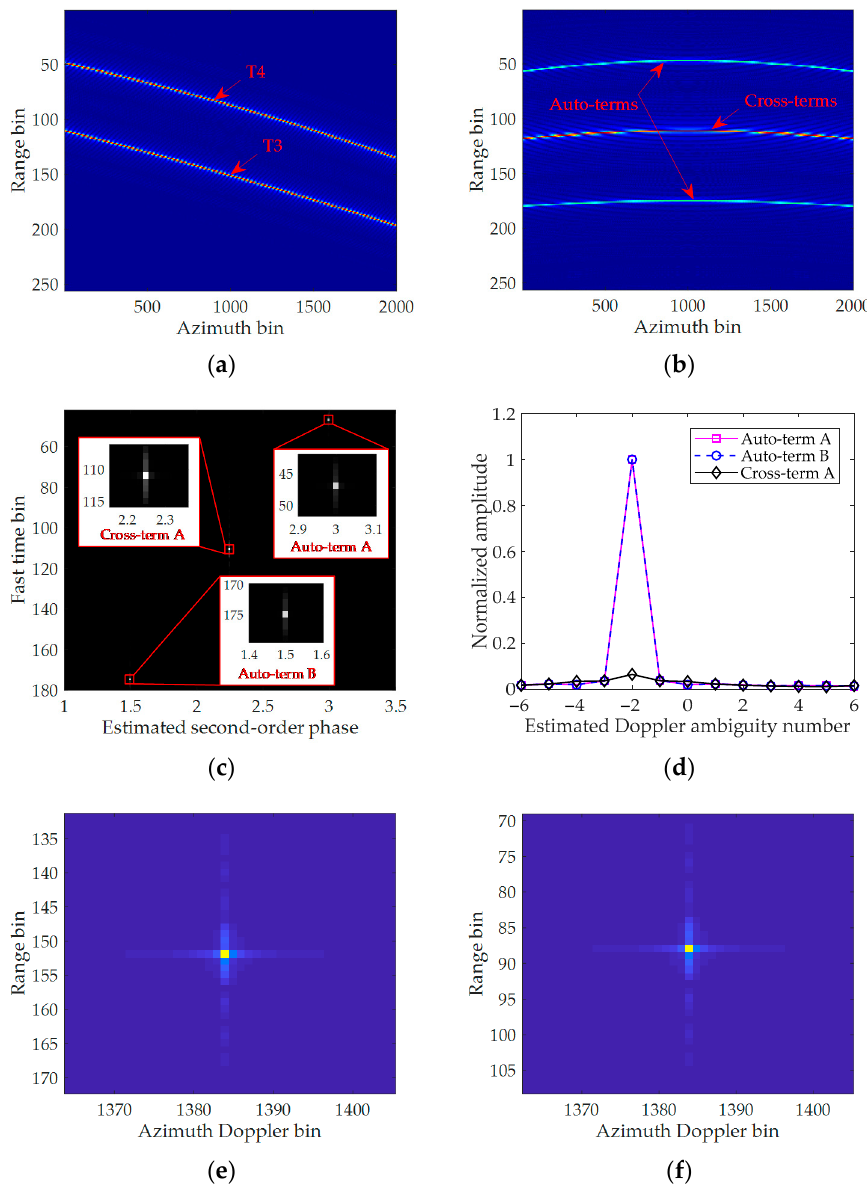
Figure 4. Results of simulation example B: ( a ) Result of range compression. ( b ) Result of parameter separation operation in Equation (10). ( c ) MSOKT result. ( d ) Estimated result of Doppler ambiguity number. ( e ) Final refocused result of T3. ( f ) Final refocused result of T4.